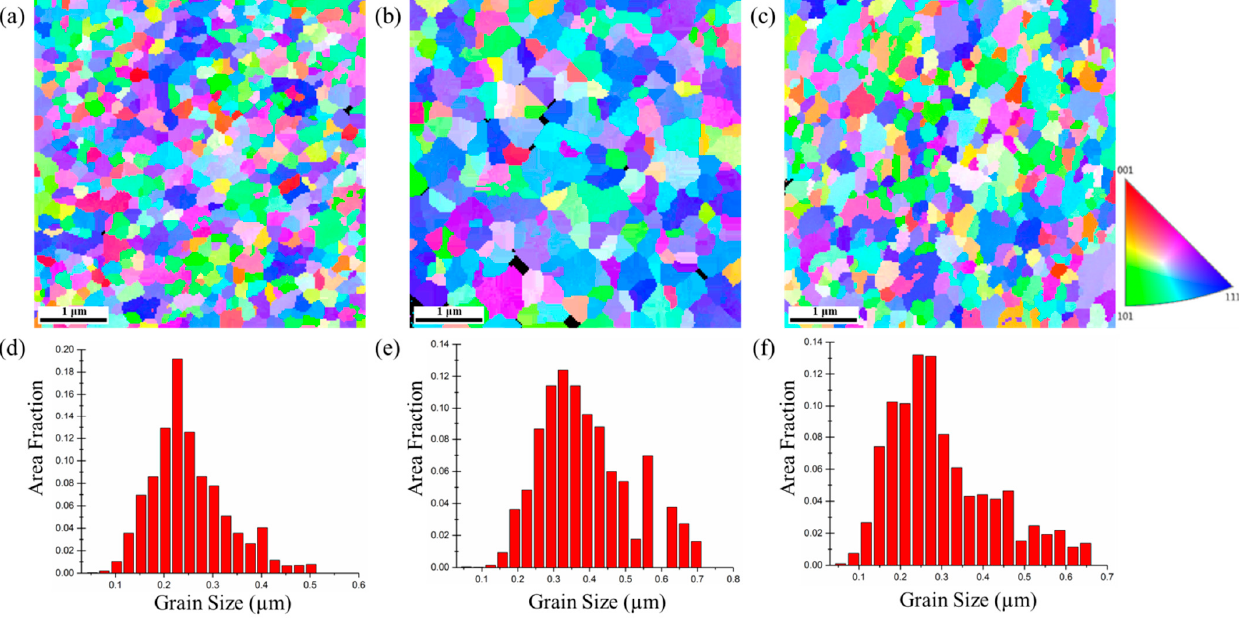
Figure 6. Plan-view EBSD micrographs and grain size distributions of the 10- μ m thick nt-Cu foils electroplated with dif- ferent concentrations of Cu 2+ : ( a , d ) 0.3 M; ( b , c ) 0.5 M; ( c , f ) 0.8 M, respectively.